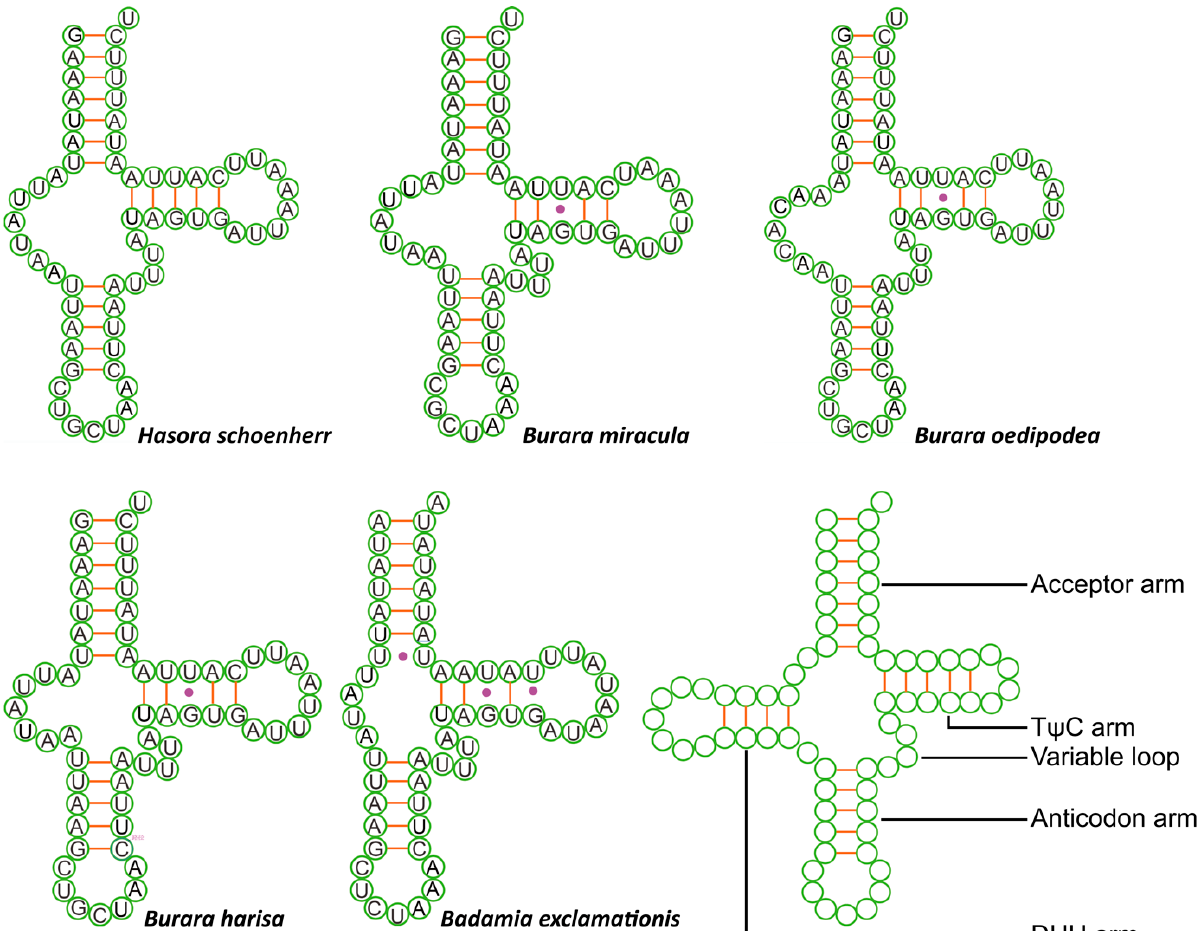
Figure 3. Predicted secondary cloverleaf structure of trnS1 (AGN) of five species. Typical structure of tRNA is shown below right.